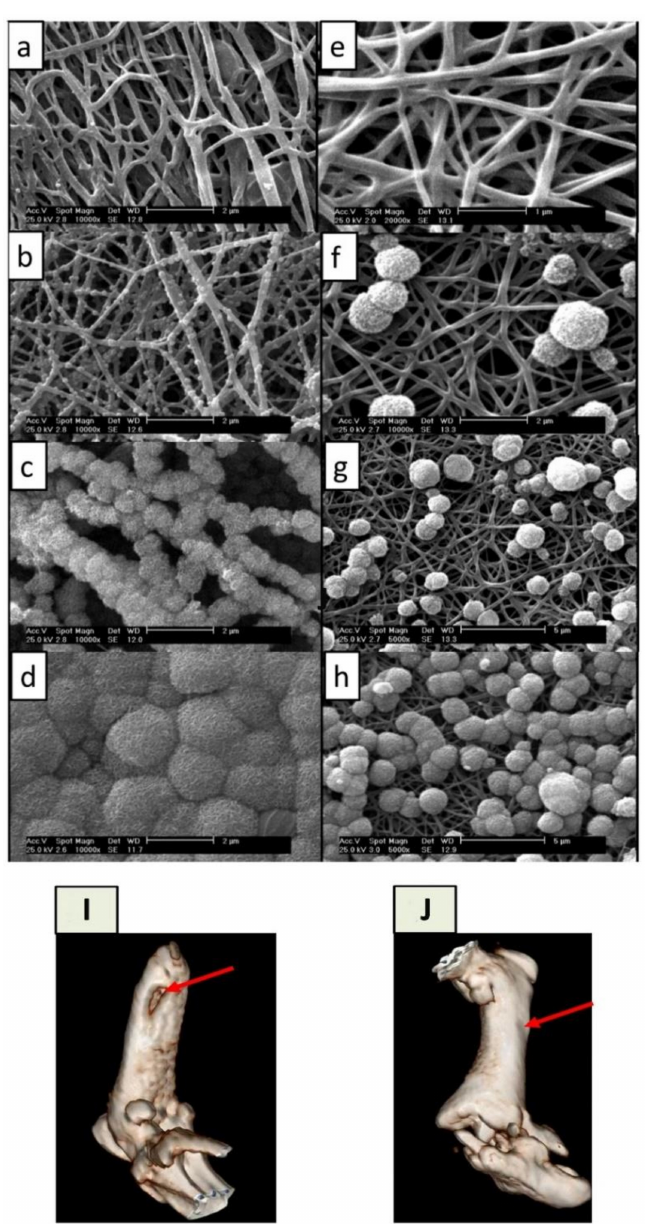
Figure 5. Scanning electron microscope (SEM) images of pristine carbon nanofibers (P-CNFs) and pre-treated carbon nanofibers (T-CNFs) incubated in a normal SBF. ( a ) T-CNFs-12 h, ( b ) T-CNFs-24 h, ( c ) T-CNFs-48 h, ( d ) T-CNFs-72 h, ( e ) P-CNFs-12 h, ( f ) P-CNFs-24, ( g ) P-CNFs-48 h, and ( h ) P-CNFs-72 h. ( i , j ) 3D computed tomography (CT) imaging of in vivo repair of a defective femur via mineralized carbon nanofibers (M-CNFs). Diagnostic 3D imaging (CT scan) of femur bone defects after 8 weeks of injury. The arrow shows the unrepaired defective site in the control group ( i ) and the bone defect repaired by normal tissue growth caused by the M-CNFs ( j ). Reprinted with permission